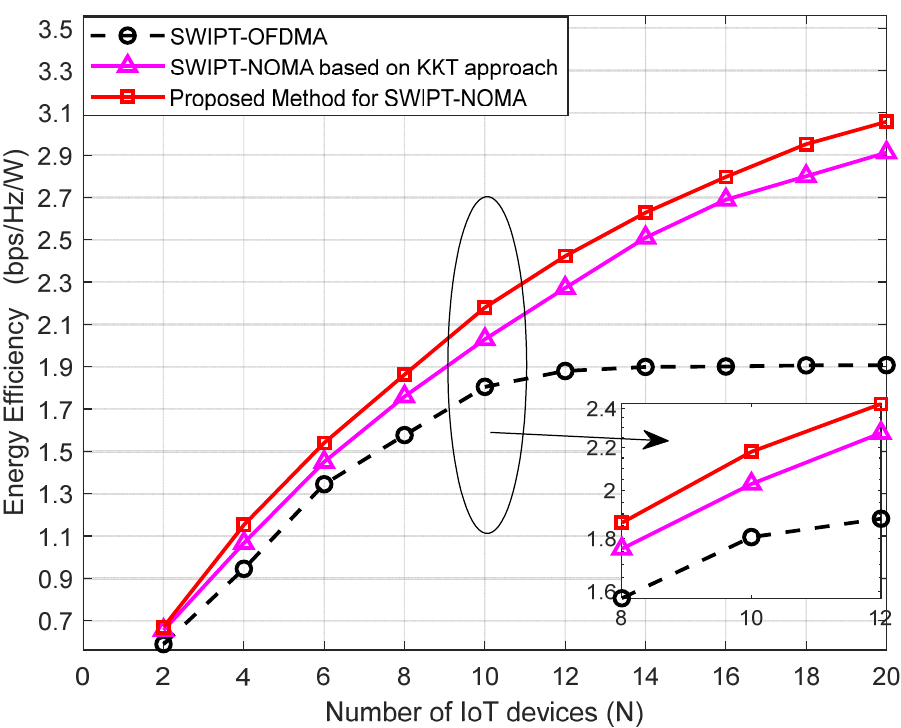
Figure 4. Energy efficiency against the number of IIoT devices.